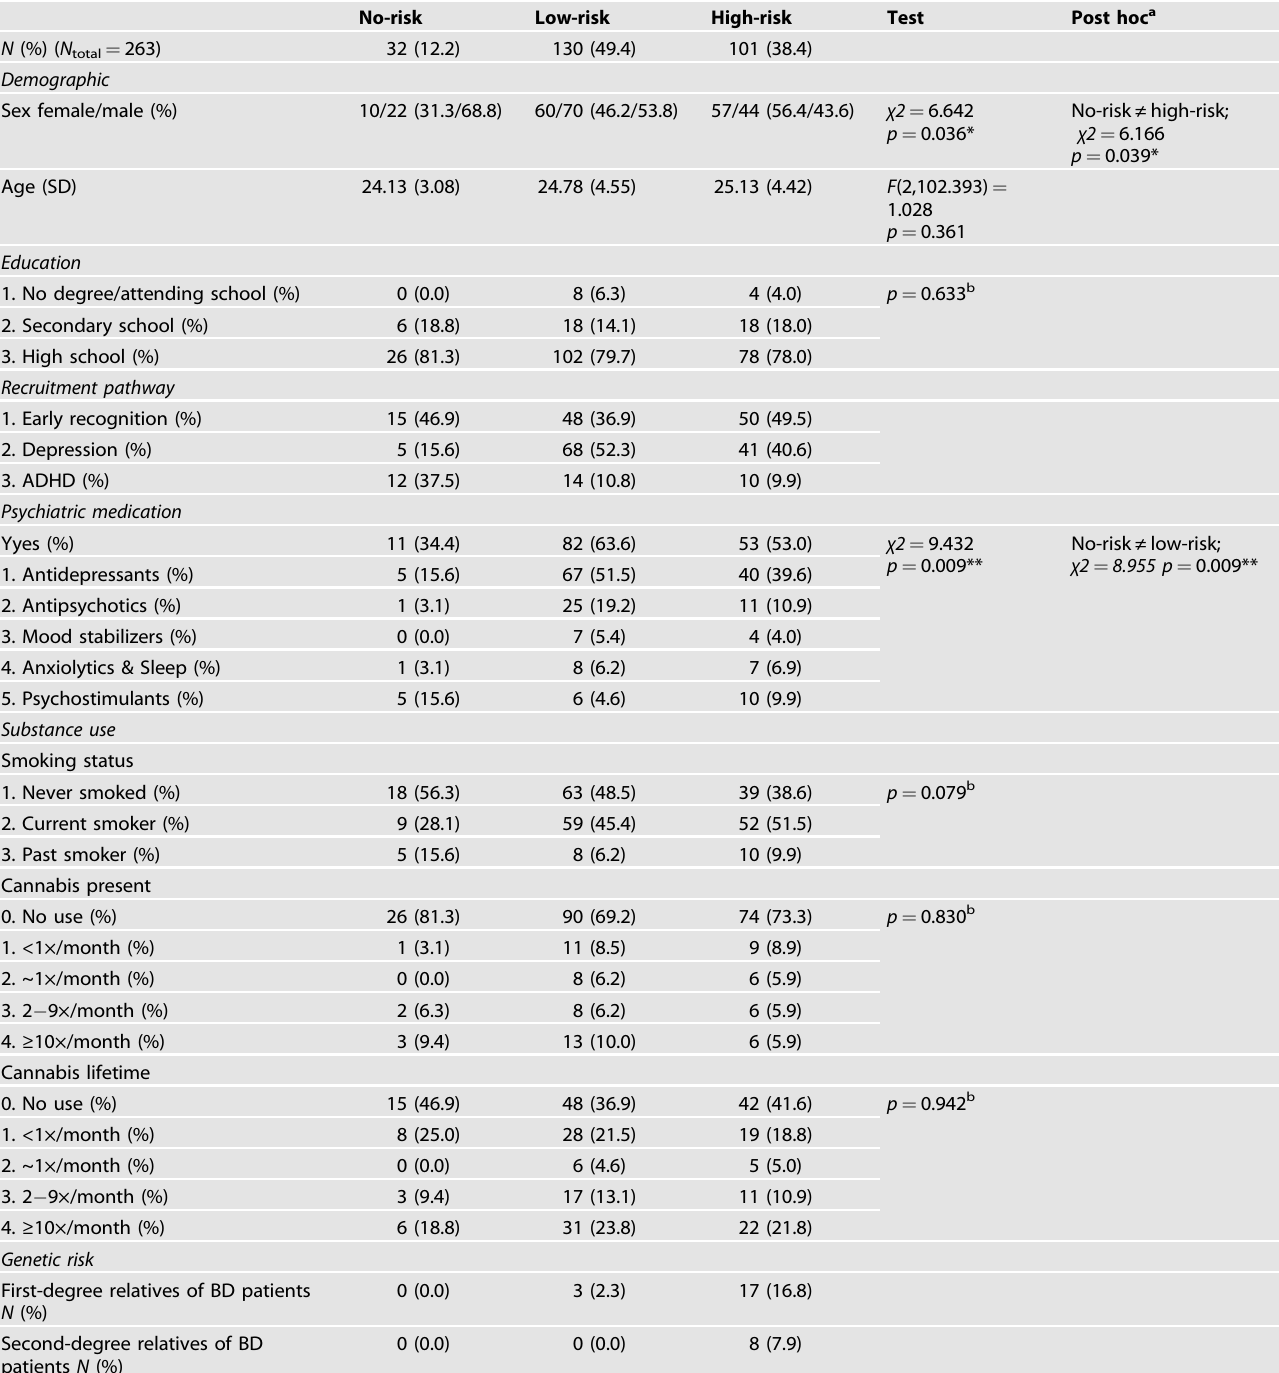
Table 1. Socio-demographic characteristics. In order to assess the risk-associated structural alterations in help-seeking individuals, we divided the participants into no-risk, low-risk, and high-risk groups using the EPI bipolar assessment